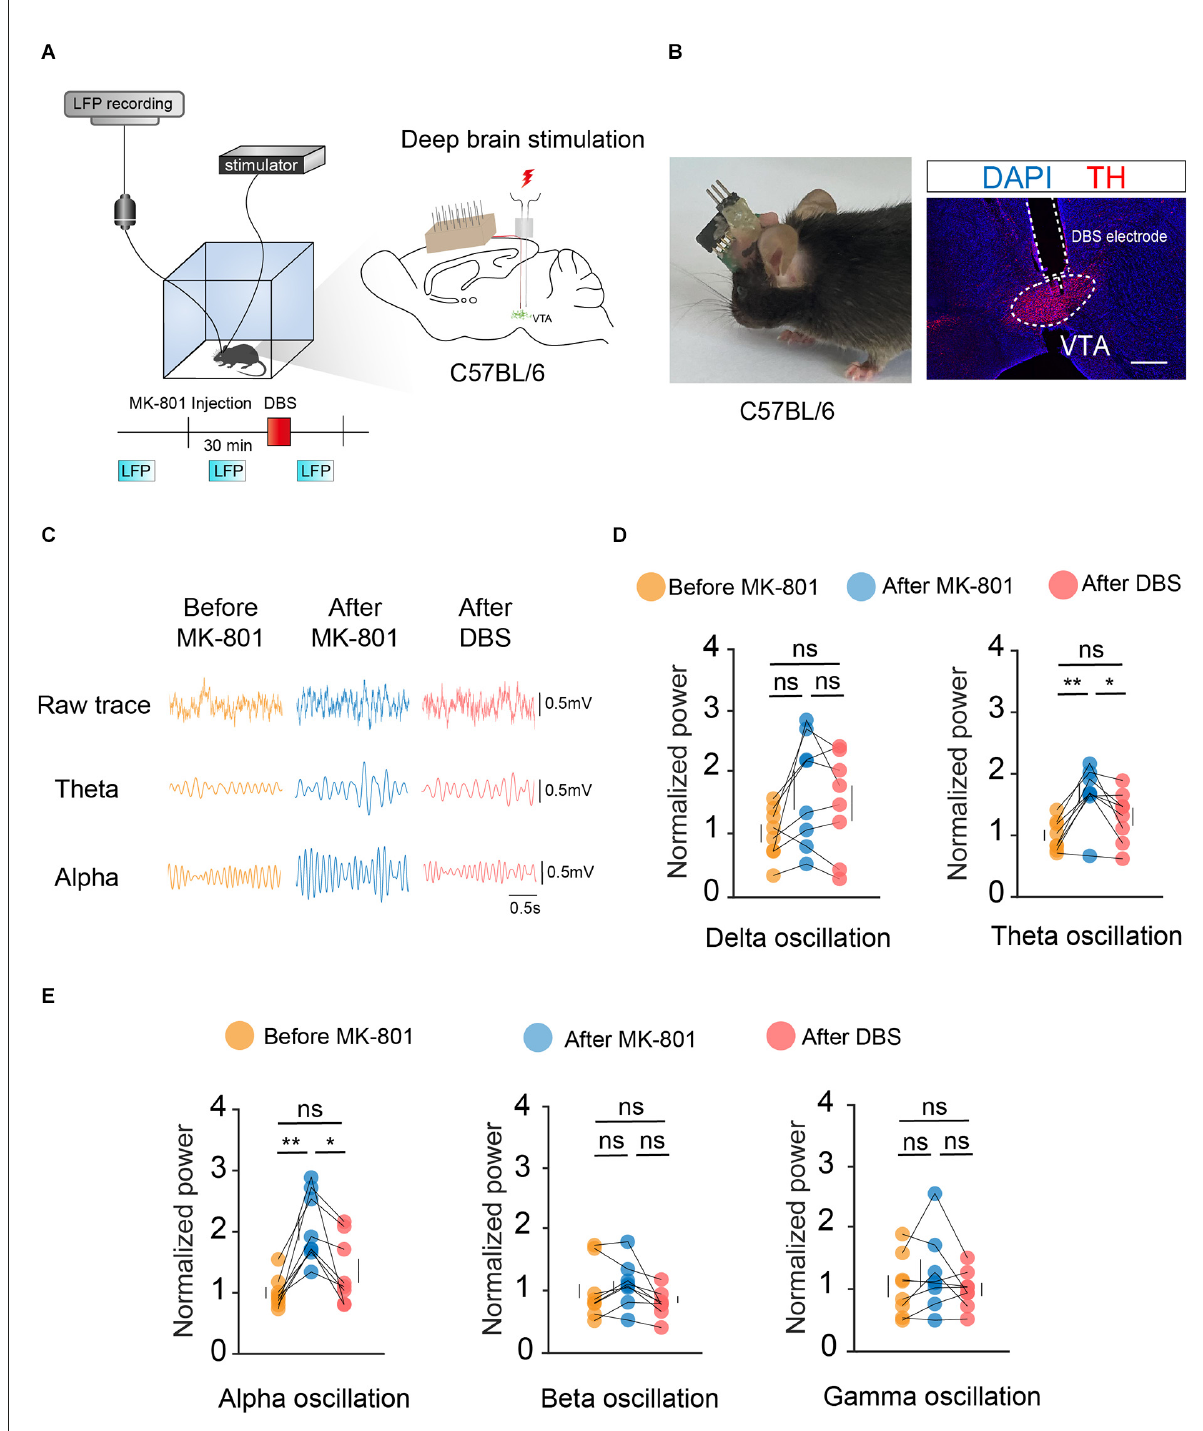
FIGURE2 DBS of the VTA reverses the local LFPs caused by MK-801 injection. (A) Left: schematic of the DBS equipment and the field potential recording system. Right: schematic of in vivo electrophysiological electrode and DBS electrode implantation. (B) Left: actual view of the two electrodes on the head of a mouse. Right: white dashed lines indicate the location of the DBS electrode and electrophysiological electrode above the VTA. Scale bar, 300 µ m. TH, tyrosine hydroxylase. (C) Example LFP trace of the mouse before MK-801 injection (i.p.), after MK-801 injection, and after DBS stimulation. (D,E) Quantification of average normalized Delta, Theta, Alpha, Beta, and Gamma band power in the VTA. Theta and alpha oscillation showed significant differences between the MK-801 injection and DBS stimulation. For all figures: one-way ANOVA with Tukey’s multiple comparisons test, * p < 0.05; ** p < 0.01; ns, no significance. N = 8 mice. All error bars represent ±